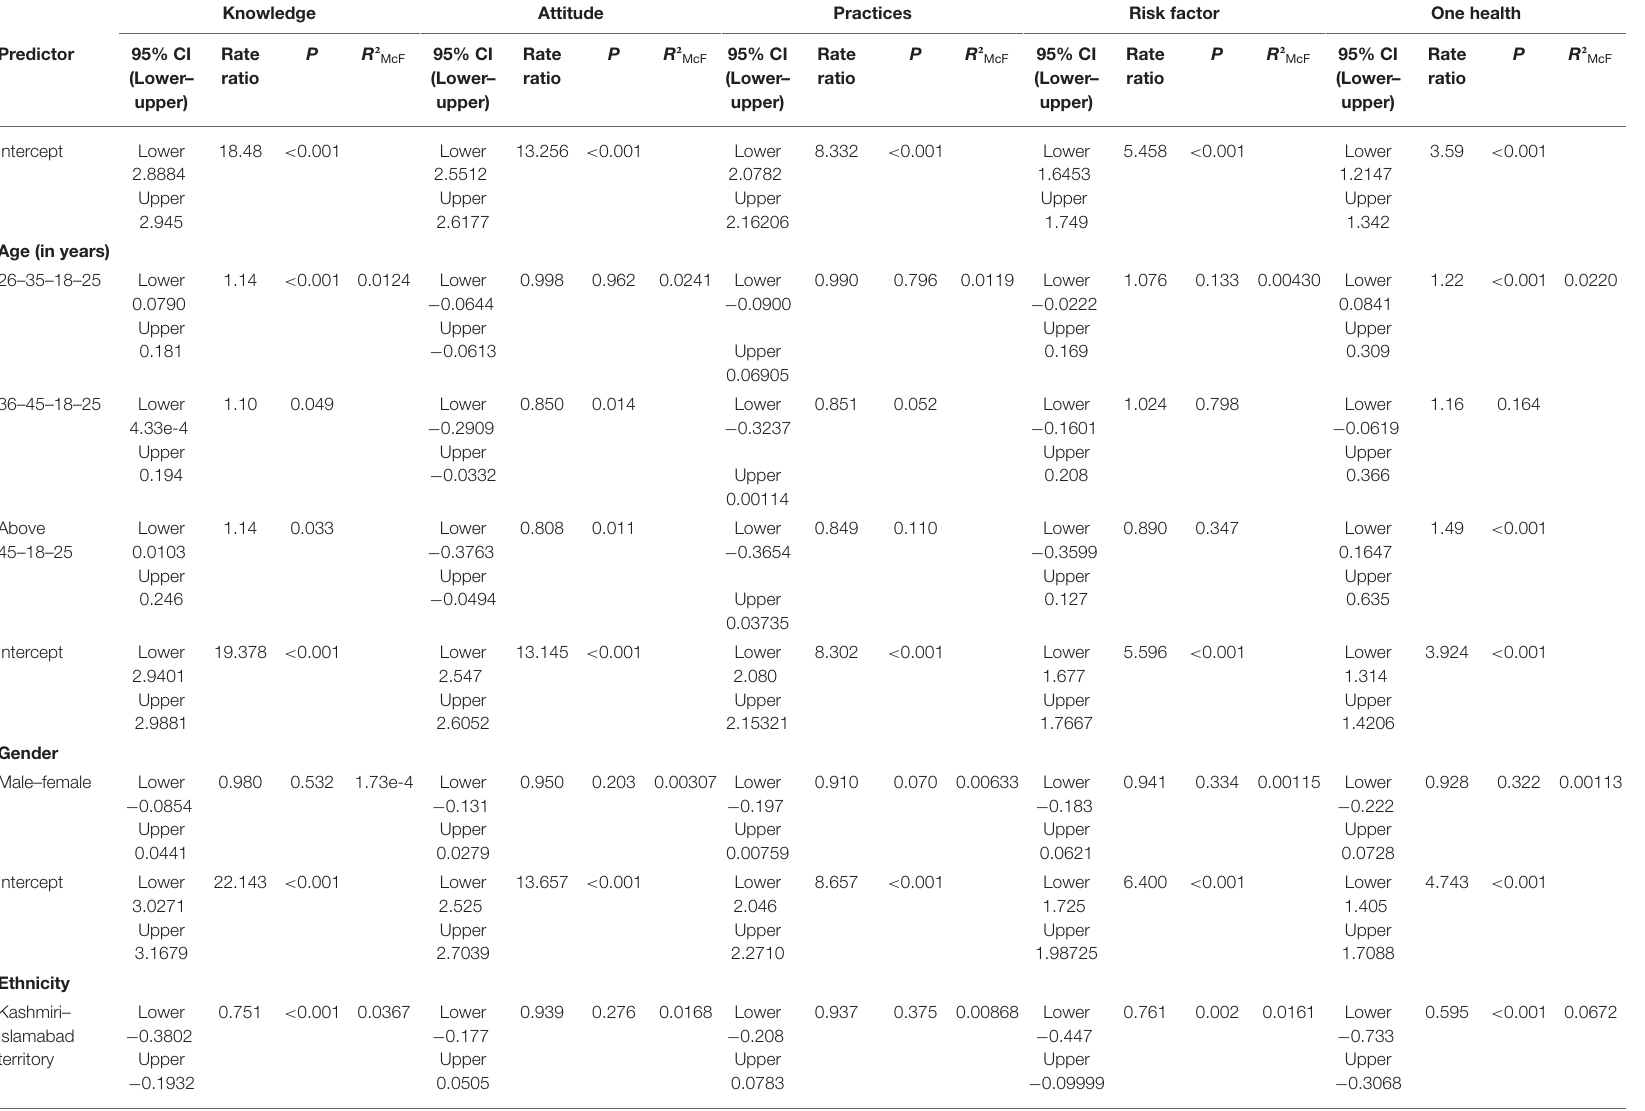
TABLE 8 | Association between demographic characteristics and knowledge, attitudes, practices, one health, and risk factors (log-linear regression). Knowledge